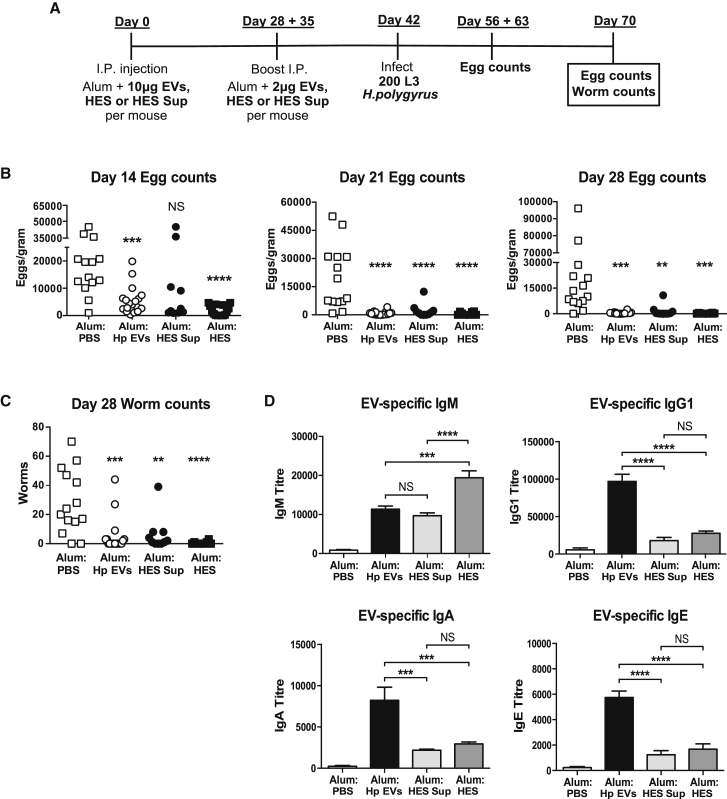
EVs Stimulate Protective Immunity against H. polygyrus Larval Challenge in C57BL/6 Mice, and They Induce Specific Antibody Responses In Vivo(A) Age-matched female C57BL/6 mice were vaccinated with EVs, HES supernatant, total HES, or PBS in alum adjuvant, prior to challenge with 200 H. polygyrus L3 larvae.(B) Egg counts per gram fecal matter were enumerated from H. polygyrus-challenged mice on days 14, 21, and 28.(C) Adult worm counts from the small intestine on day 28 in H. polygyrus-challenged mice. Data are pooled from three experiments and presented as mean values ± SD (n = 10–18 mice per group; one-way ANOVA).(D) Titers of IgM, IgG1, IgA, and IgE detectable from sera of immunized mice measured by ELISA coated with EVs. Data are representative of two independent experiments and presented as mean values ± SD (n = 5 mice per group; one-way ANOVA, ∗p < 0.05, ∗∗p < 0.01, ∗∗∗p < 0.001, and ∗∗∗∗p < 0.0001; NS, not significant).